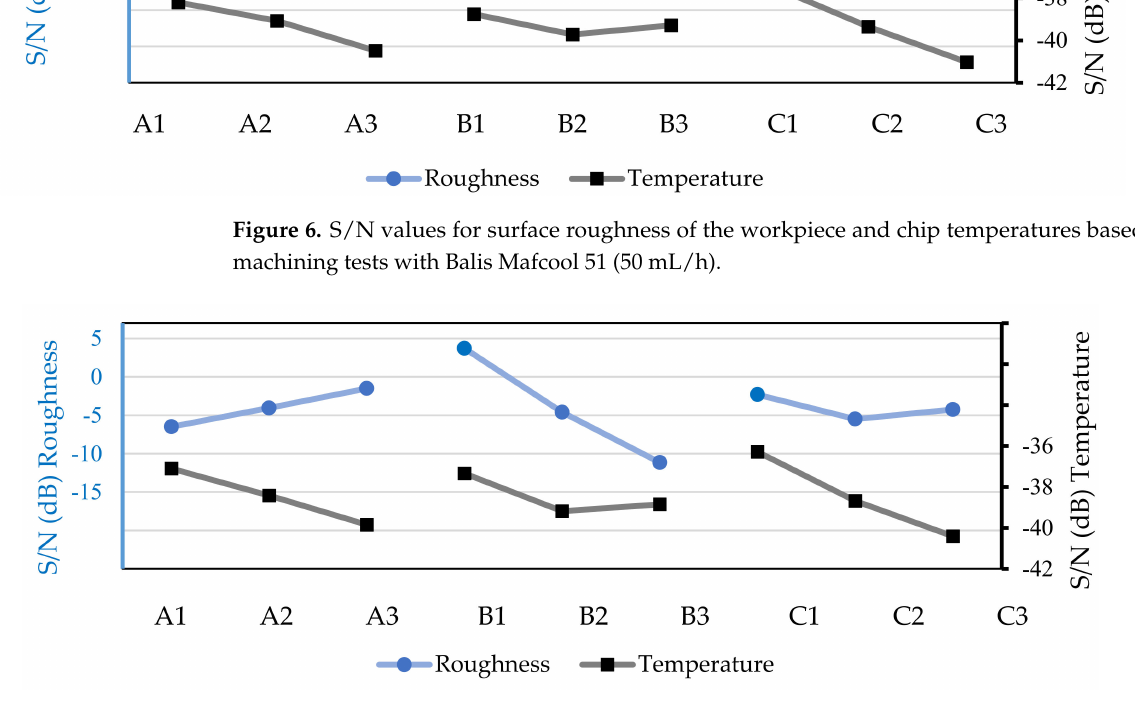
Figure 7. S/N values for surface roughness of the workpiece and chip temperatures based on the machining tests with Balis Mafcool 51 (100 mL/h).